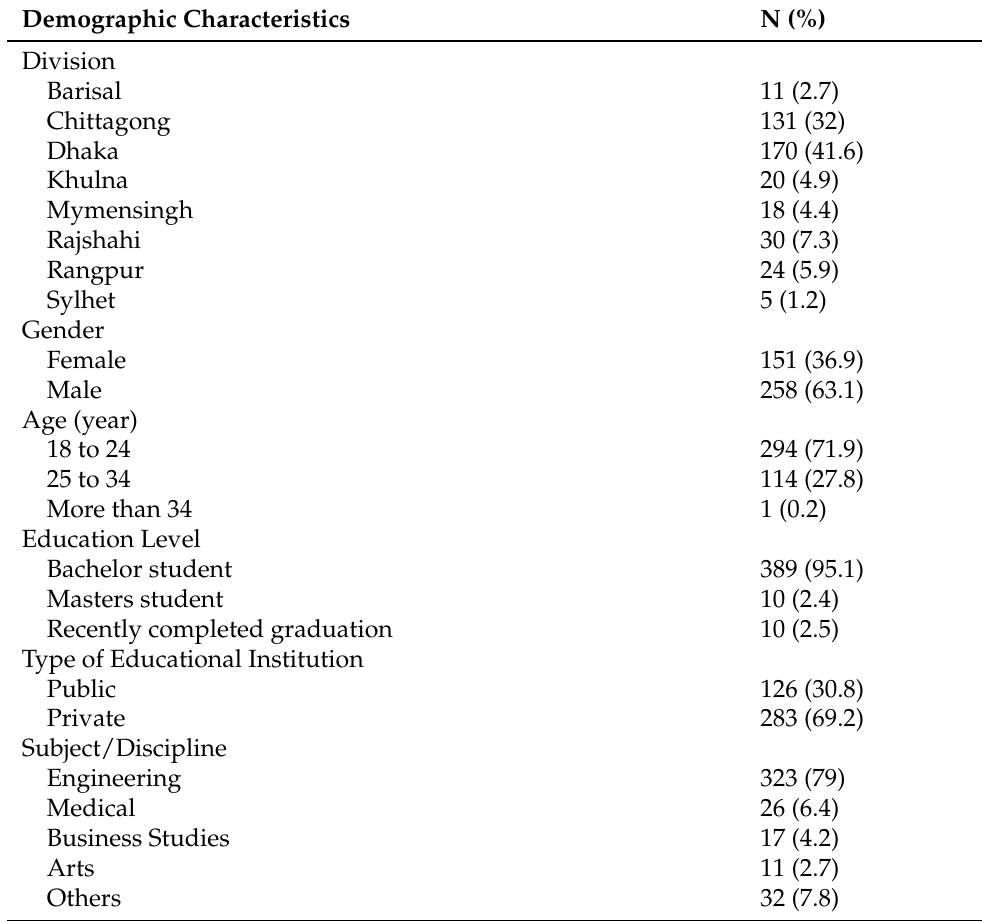
Table 1. Demographic Characteristics of the Survey Participants (N =